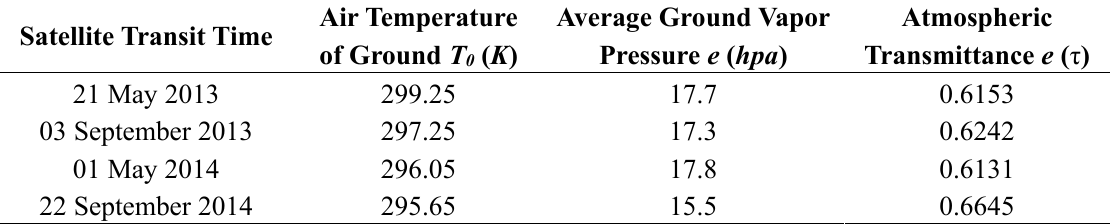
Table 2. Atmospheric information of Xuzhou